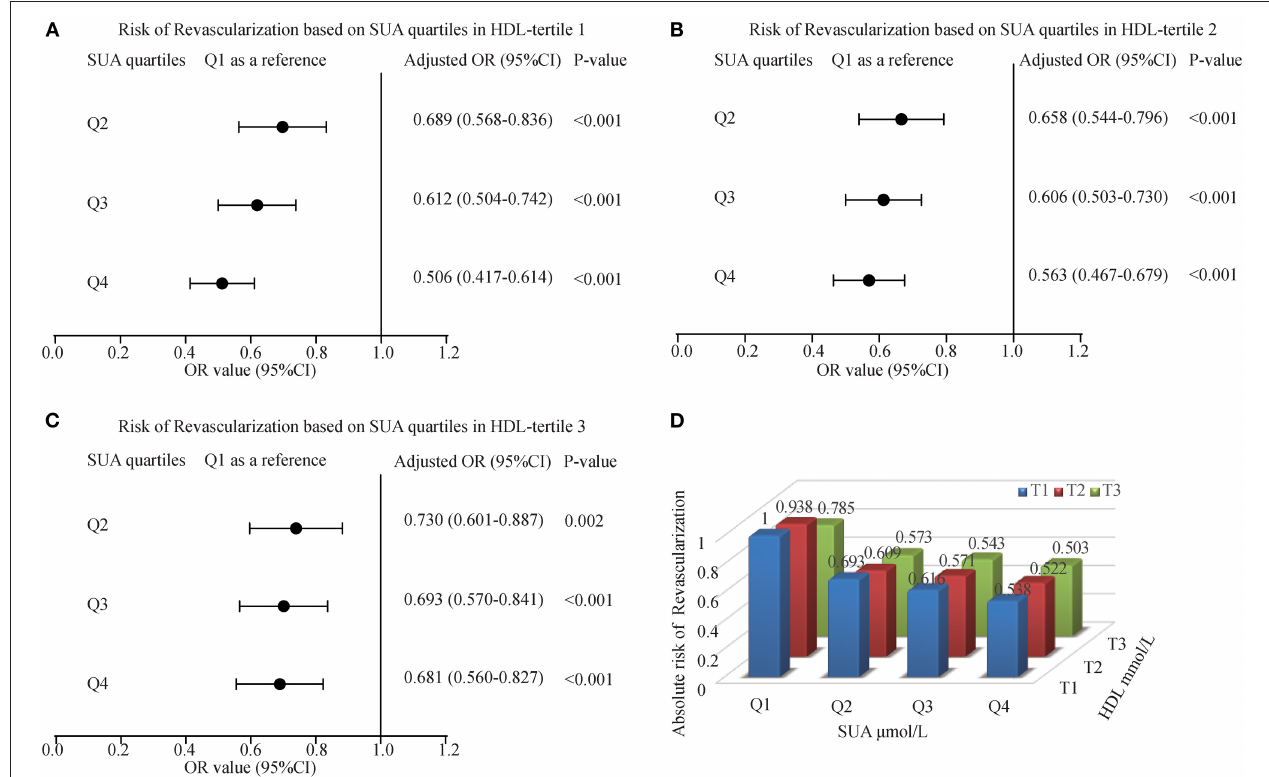
FIGURE 5 | The risk of myocardial revascularization (MRT) based on baseline SUA quartiles in ACS patients. ( A ) Adjusted odd ratios for MRT in HDL-tertile 1; ( B ) Adjusted odd ratios for MRT in HDL-tertile 2; ( C ) Adjusted odd ratios for MRT in HDL-tertile 3; ( D ) Adjusted odd ratios for MRT in each group by quartiles of the SUA and tertiles of the HDL. Adjusted for age, gender, smoking, LDL, TG, Glucose, Creatinine, Statin use, and Hypertension.